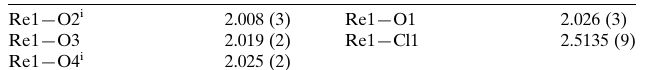
Selected bond lengths (A˚